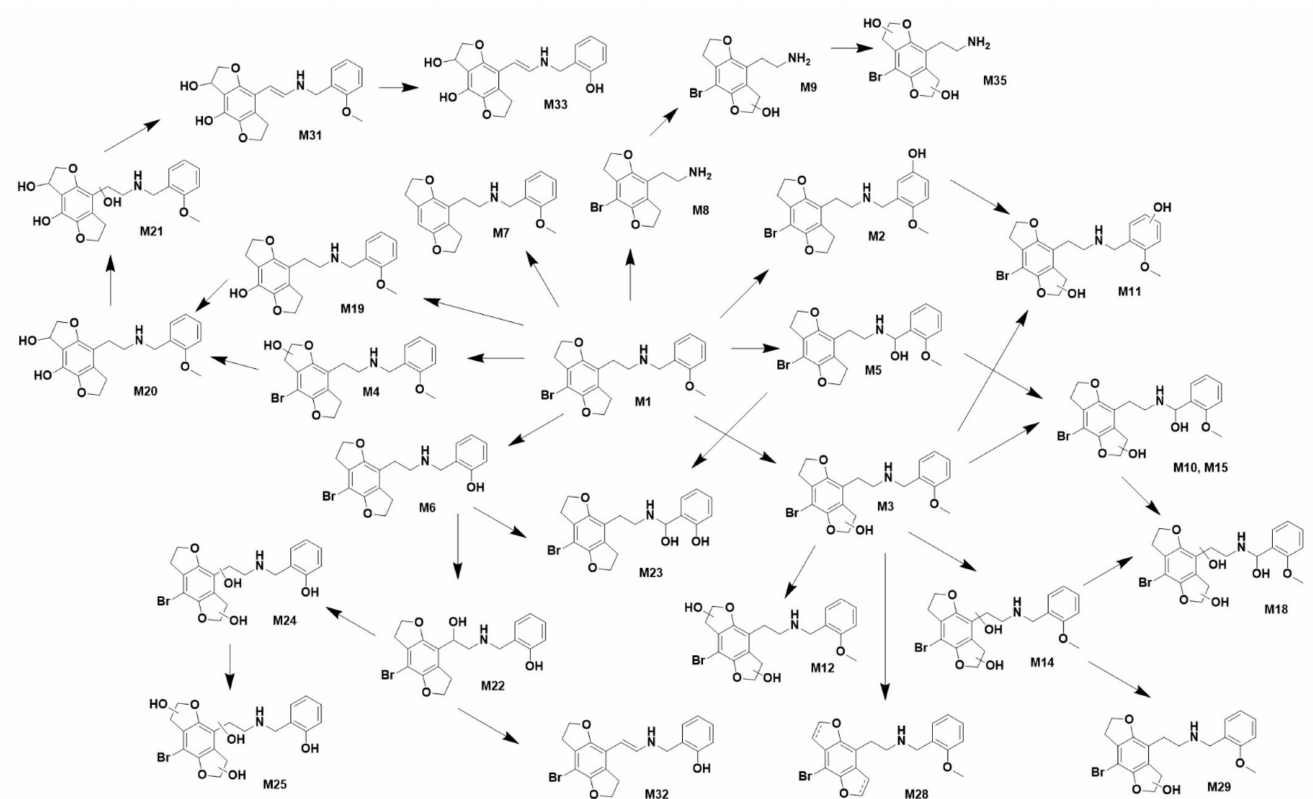
Figure 1. Metabolic pathways of